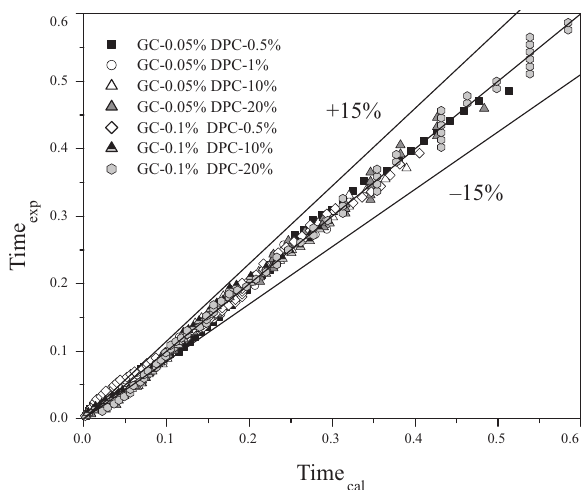
Fig. 4. Correlation between experimental values (timeexp) and calculated (timecal) by means of the classical Lucas–Washburn equation for the entire process of the imbibition process